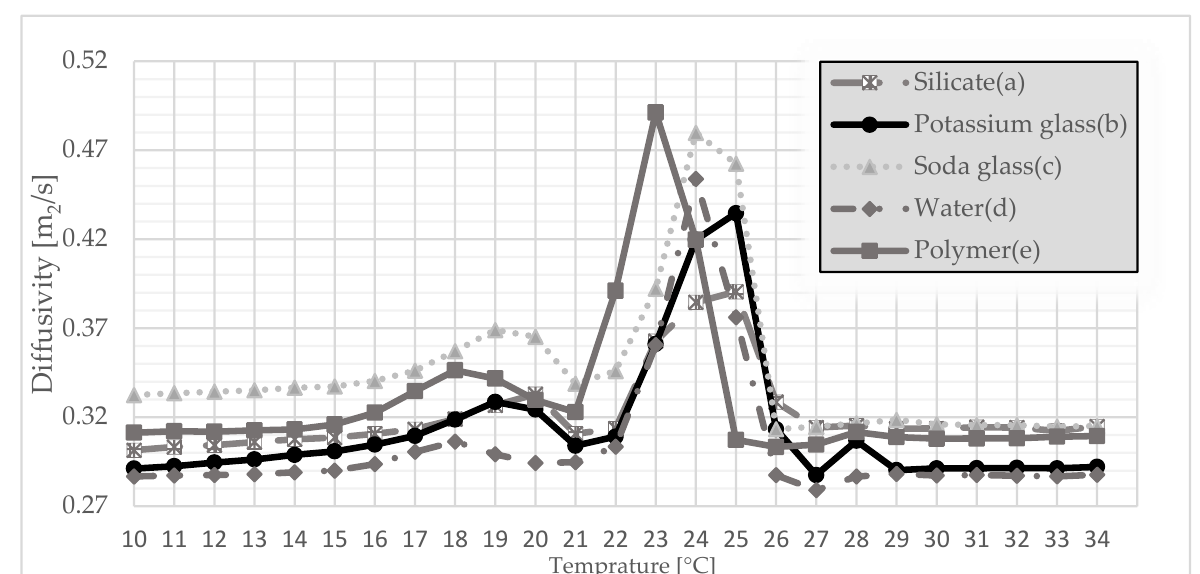
Figure 8. Thermal diffusivity of coated granulate: (a) silicate; (b) potassium glass; (c) soda glass; (d)